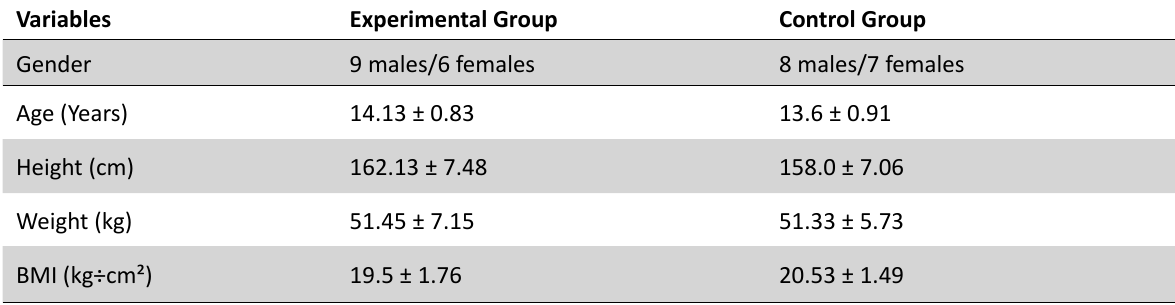
Table 1. Demographic Data of Experimental Group and Control Group